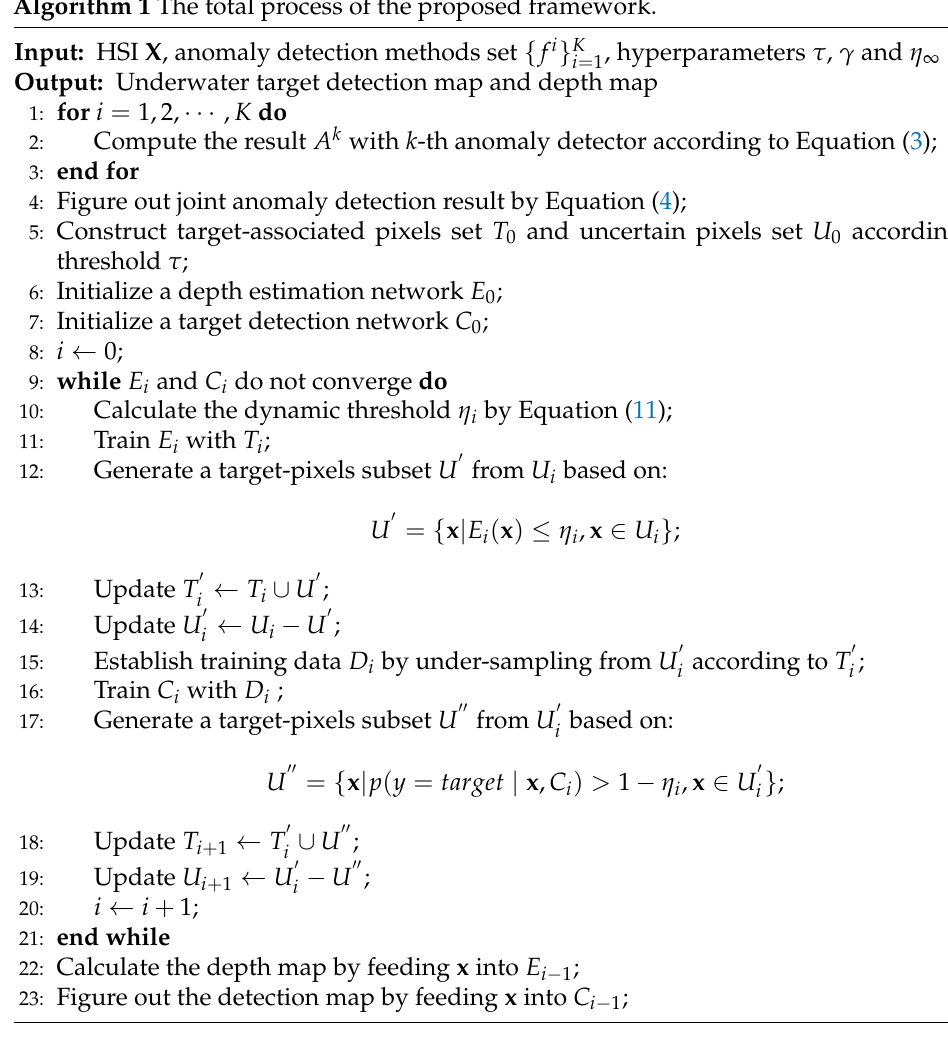
Algorithm 1 The total process of the proposed